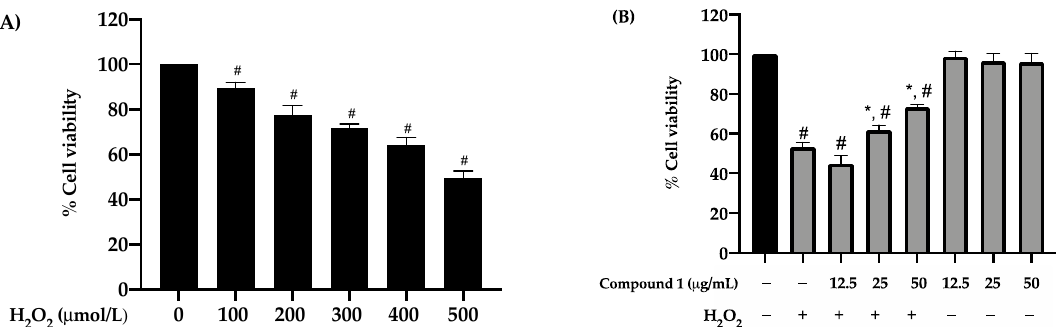
Figure 3. Effect of compound 1 on cell viability in HaCaT keratinocytes induced oxidative stress with H 2 O 2 . ( A ) Cells were treated with H 2 O 2 (100–500 µ mol/L) for 1 h. ( B ) Cells were pre-treated with compound 1 (12.5, 25, and 50 µ g/mL) prior to exposure to 500 µ mol/L H 2 O 2 for 24 h. After the treatment, the percent cell viability was measured using the MTT assay. Graphs exhibited mean ± SD values of four replications. * p < 0.05 indicates significant differences from the H 2 O 2 induction group, # p < 0.05 indicates significant differences from the control